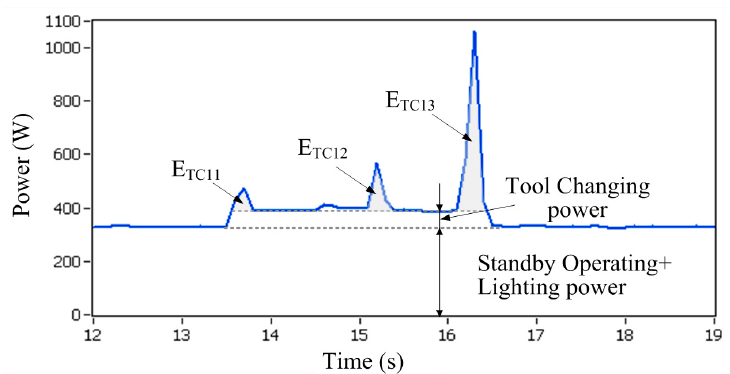
Figure 9. Power curve of tool changing (off → on).